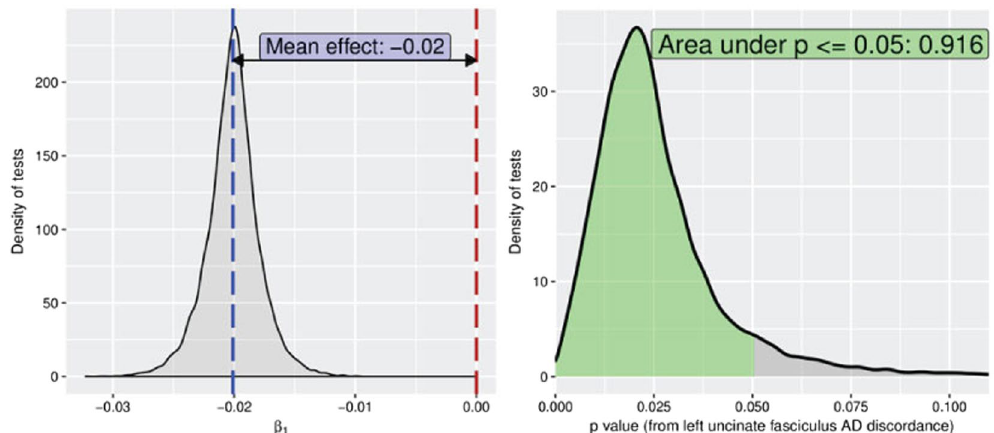
Figure 4. Distribution of beta (left panel) and p values (right panel) of association between anxiety and AD difference score after switching twin assignment 10 4 times. 92% of the p values were lower than